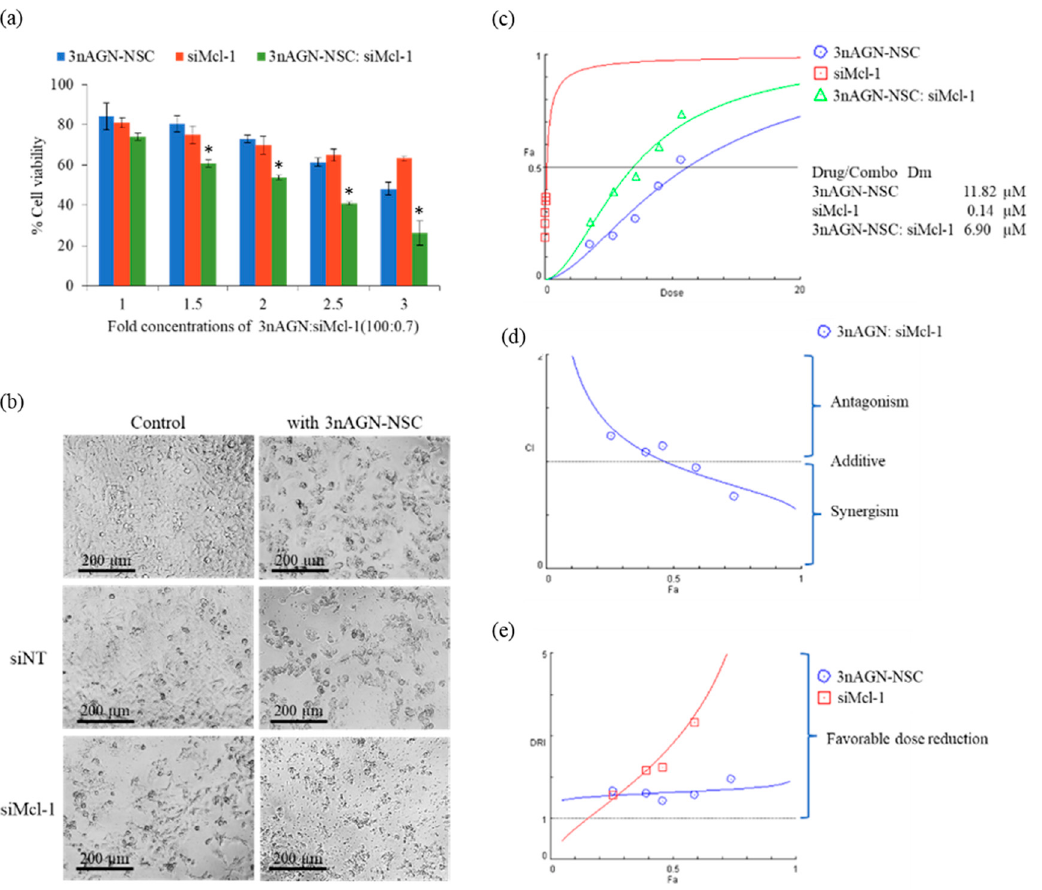
Figure 4. The constant ratio experiment of 3nAGN-NSC:siMcl-1 at 100:0.7; ( a ) the percentage of cell viability in MCF-7 cells and ( b ) morphology of the cells under an inverted fluorescence microscope (40X) after 72-h treatment with 3nAGN-NSC and siMcl-1 at the doses of 10.71 and 0.075 µM, respectively. The actual points are shown as symbols, and the simulated lines were generated from CompuSyn which are presented in ( c ) median effect plots, ( d ) CI plots (CI-Fa), and ( e ) DRI plots (DRI- Fa). * The data signify a significant difference from a single treatment with siMcl-1 or 3nAGN-NSC ( p < 0.05).